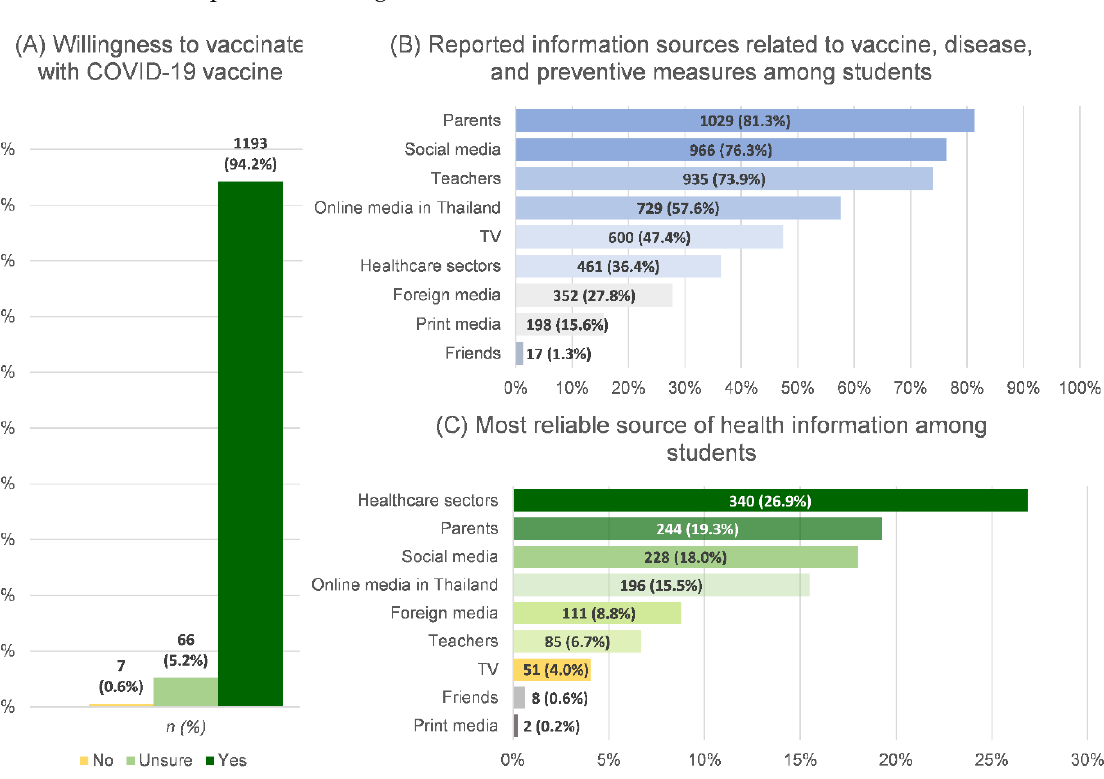
Figure 5. Students’ willingness to get vaccinated with COVID-19 vaccine and their health-information sources.